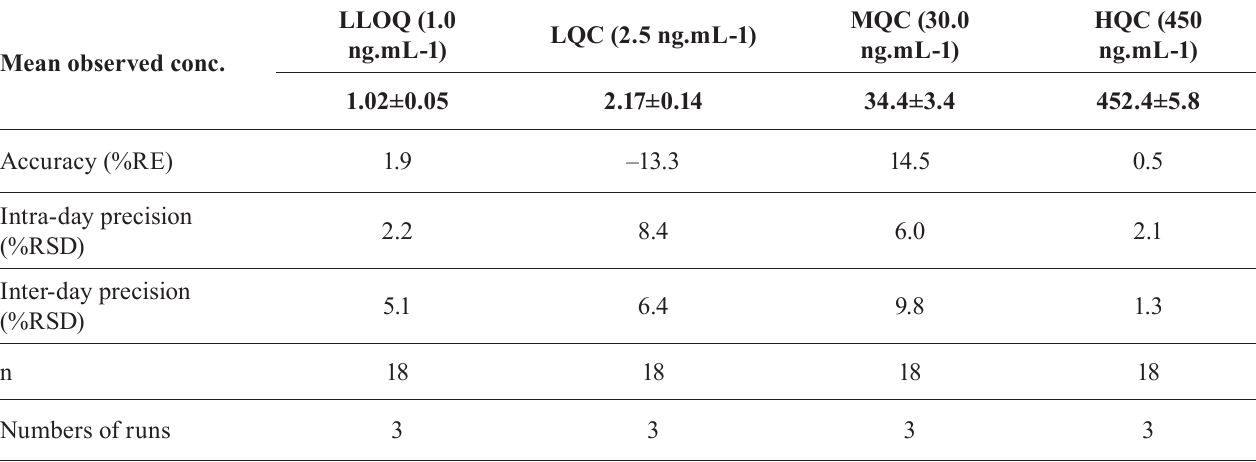
TABLE I - A ssay performance of lobetyolin QC samples in rat plasma